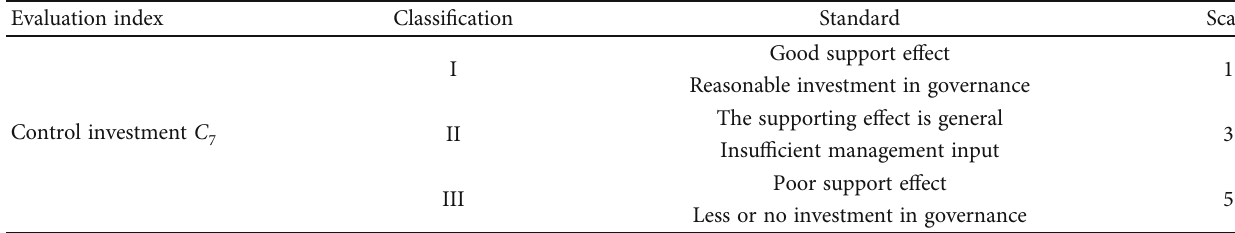
Table 10: Governance investment classi fi